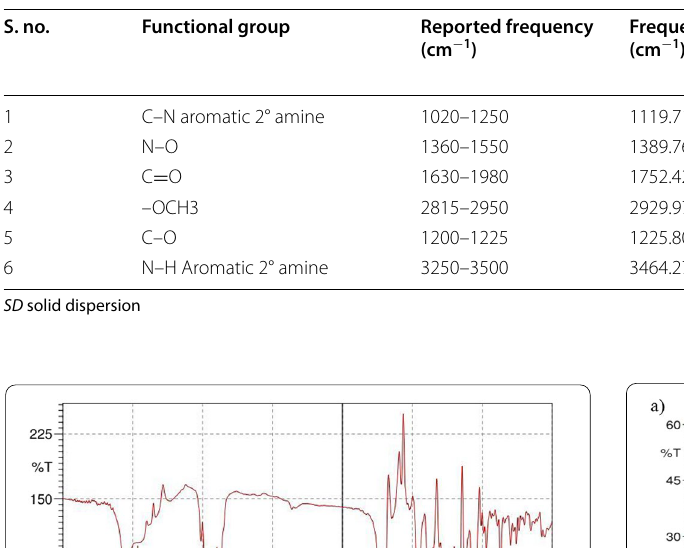
Table 4 FT-IR result [23]